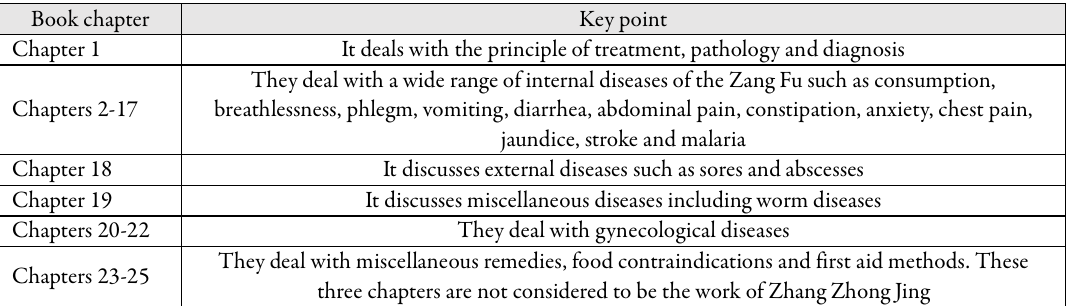
Table 17. Contents of the text of The Jin Gui Yao